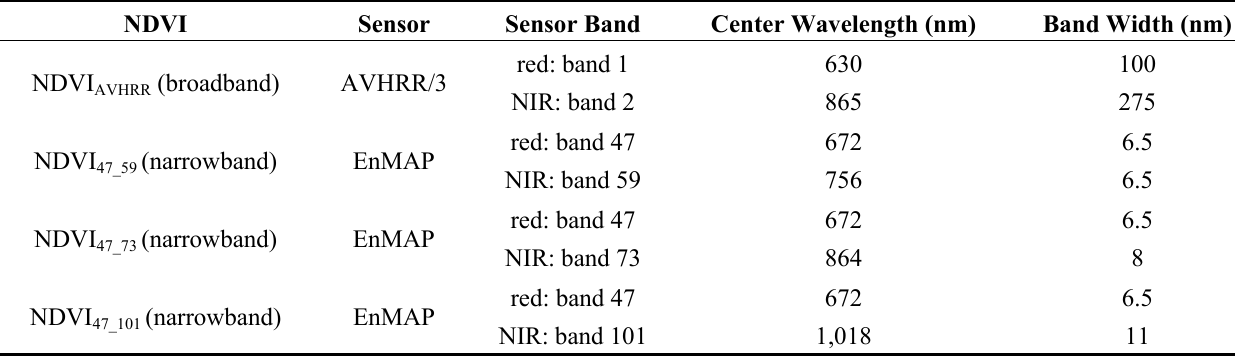
Table 1. Center wavelengths and band width of the broadband and narrowband Normalized Difference Vegetation Index (NDVIs) used in this study, based on the spectral response curves of the Advanced Very High Resolution Radiometer (AVHRR) and Environmental Mapping and Analysis Program (EnMAP) sensors.